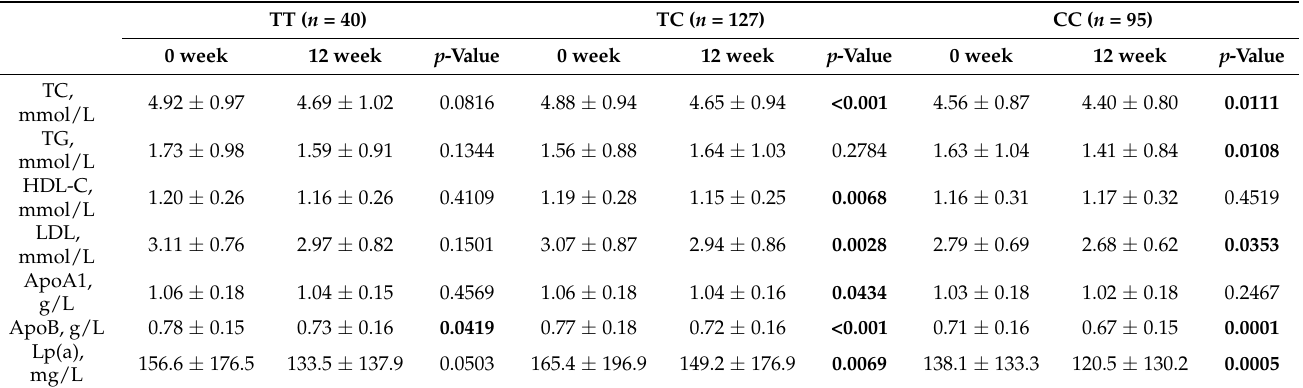
Table 3. The effect of 12-week MTX treatment on lipid levels according to the genotype of AnxA6 rs11960458 in 262 psoriatic